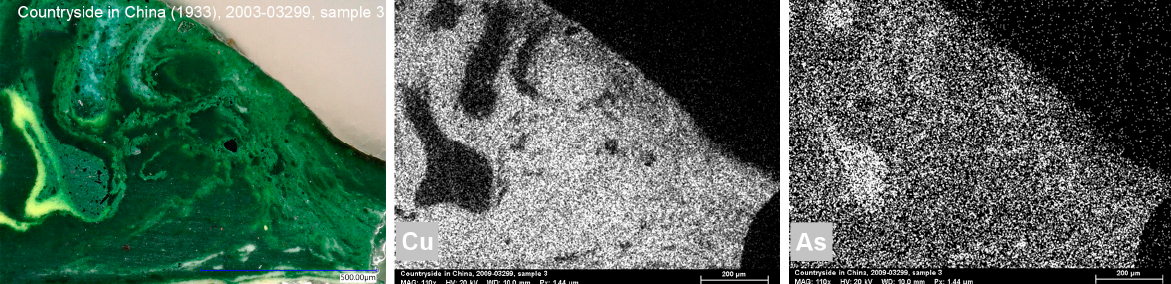
Figure 10. Optical microscopy image of the paint cross-section of sample 3 obtained from Countryside in China , 1933 and captured at 100× magnification (top-left), followed by SEM-EDS elemental distribution maps. The intensity of the signal of each element is represented by a range of grey tones: white represents high intensity and black represents low intensity. A concomitant presence of highly intensive copper and arsenic signals suggests the use of emerald green.